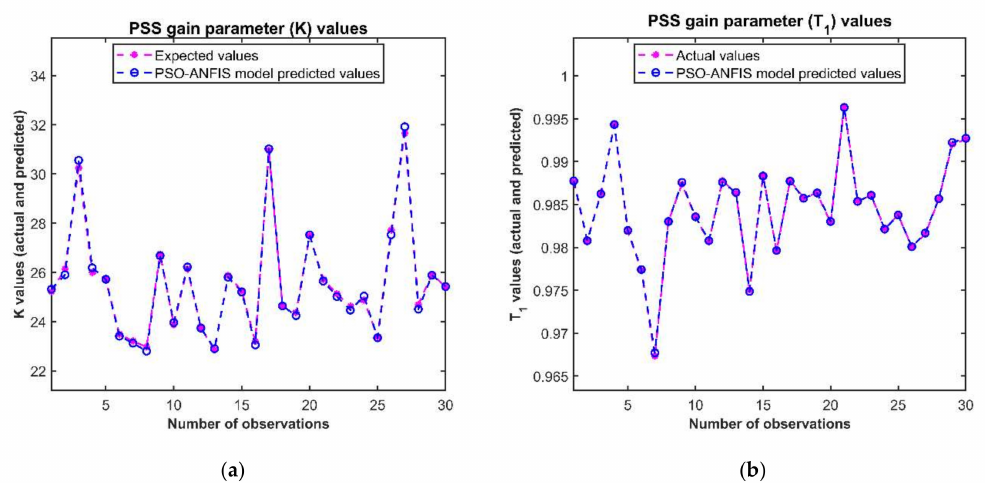
Figure 11. Comparisons of the actual and the PSO-ANFIS models predicted PSS key parameters values for randomly selected 30 samples from the second network test datasets; ( a ) PSS gain parameter ( K ) and ( b ) PSS time constant parameter ( T 1